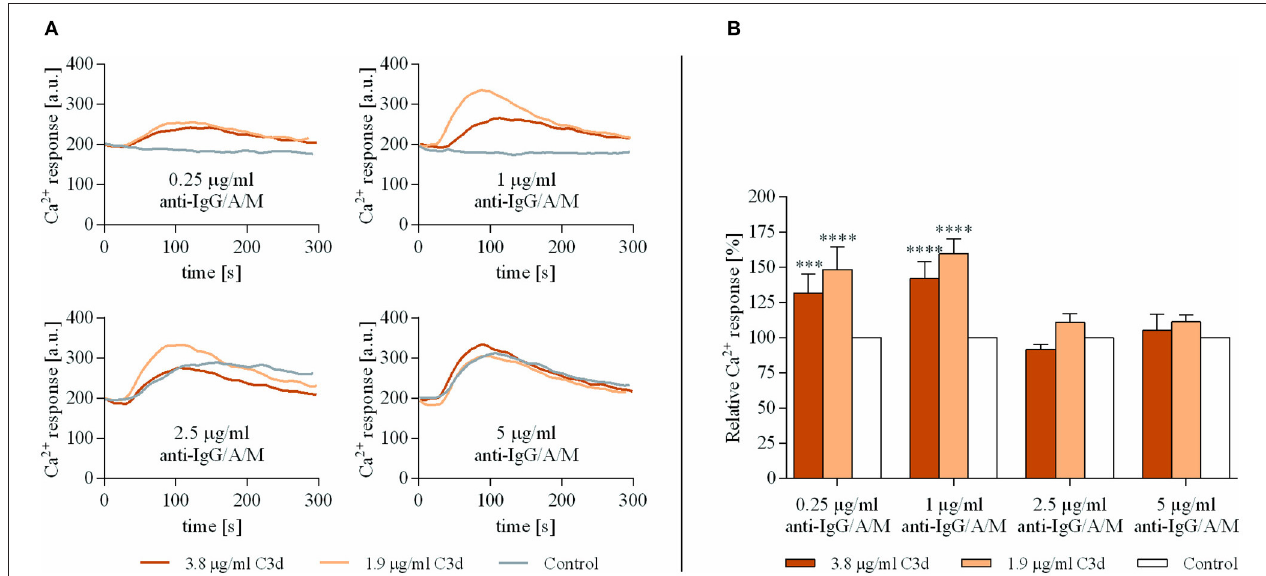
FIGURE 1 | Co-ligation of complement receptor type 2 (CR2) with suboptimally stimulated B-cell receptor (BCR) elevates the Ca 2 + response of human B cells. Resting human B cells were treated with complexes consisting of either streptavidin-conjugated anti-immunoglobulin G (IgG)/A/M (control samples) or streptavidin-linked anti-IgG/A/M and C3d molecules in different concentrations as indicated. Changes in fluorescence intensity were assessed for 300s via flow cytometry and the Ca 2 + response kinetics were examined. Response curves demonstrate the result of one representative experiment depicting mean fluorescence intensity as a function of time (A) . The peak amplitude of each Ca 2 + response curve was presented as a relative value compared to the peak amplitude of the control samples. Diagrams show cumulative results obtained in three independent experiments displaying the mean of the relative values ± SD (B) . *** p < 0.001, **** p <